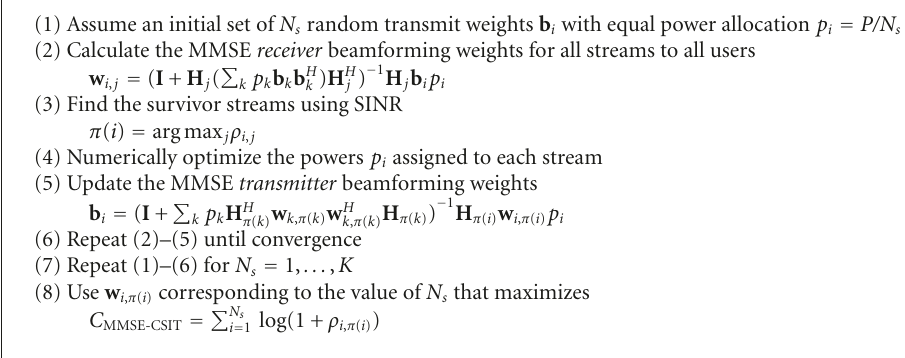
Algorithm 1: Iterative beamforming for maximization of sample expected